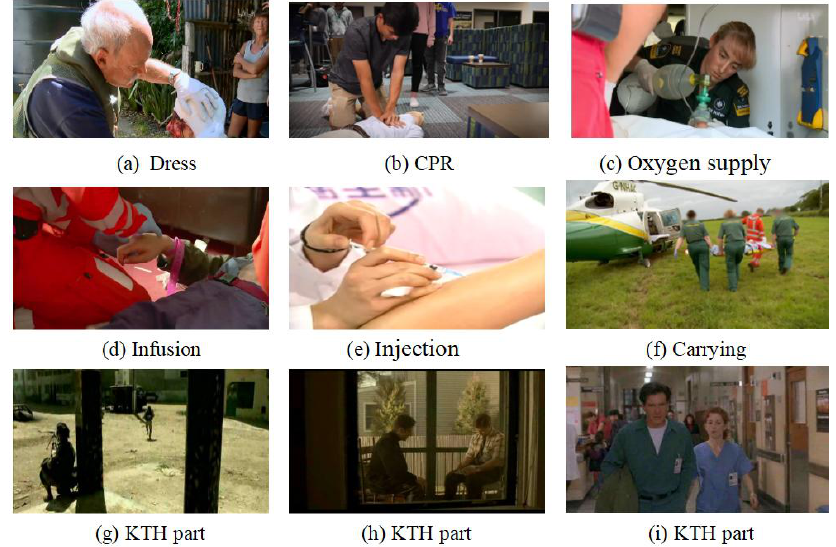
Figure 9. Some examples of the